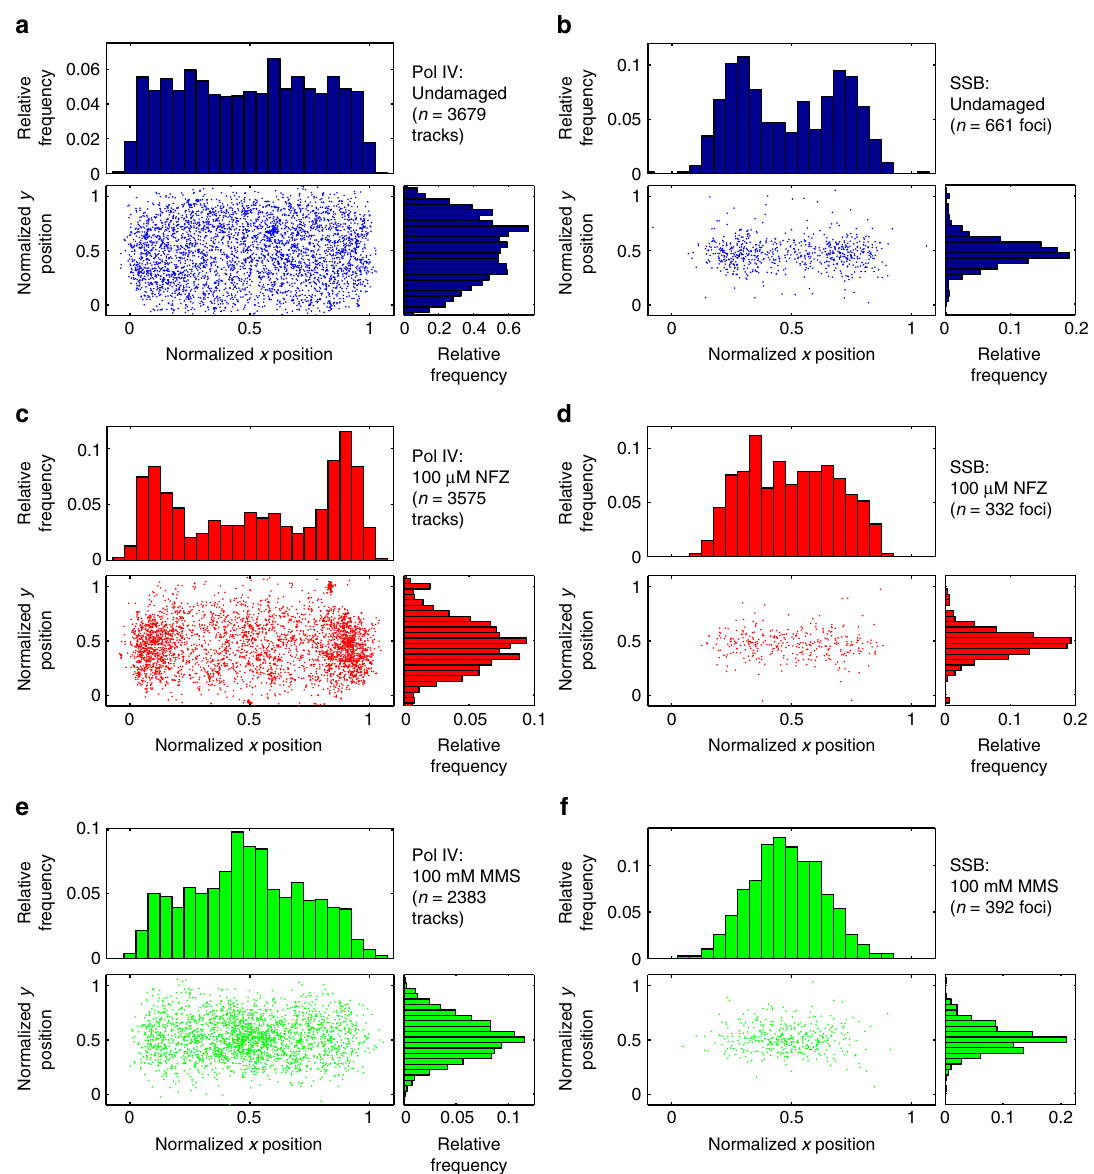
Fig. 2 Cellular localization of Pol IV-PAmCherry and SSB-mYPet in undamaged, NFZ-treated, and MMS-treated cells. Scatter plots of normalized mean coordinates of Pol IV-PAmCherry tracks and the normalized coordinates of SSB-mYPet foci in undamaged ( a , b ), 100 µ M NFZ-treated ( c, d ), and 100 mM MMS-treated ( e , f ) cells. Also shown are the projections of the scatter plots along the long ( x ) and short ( y ) cellular